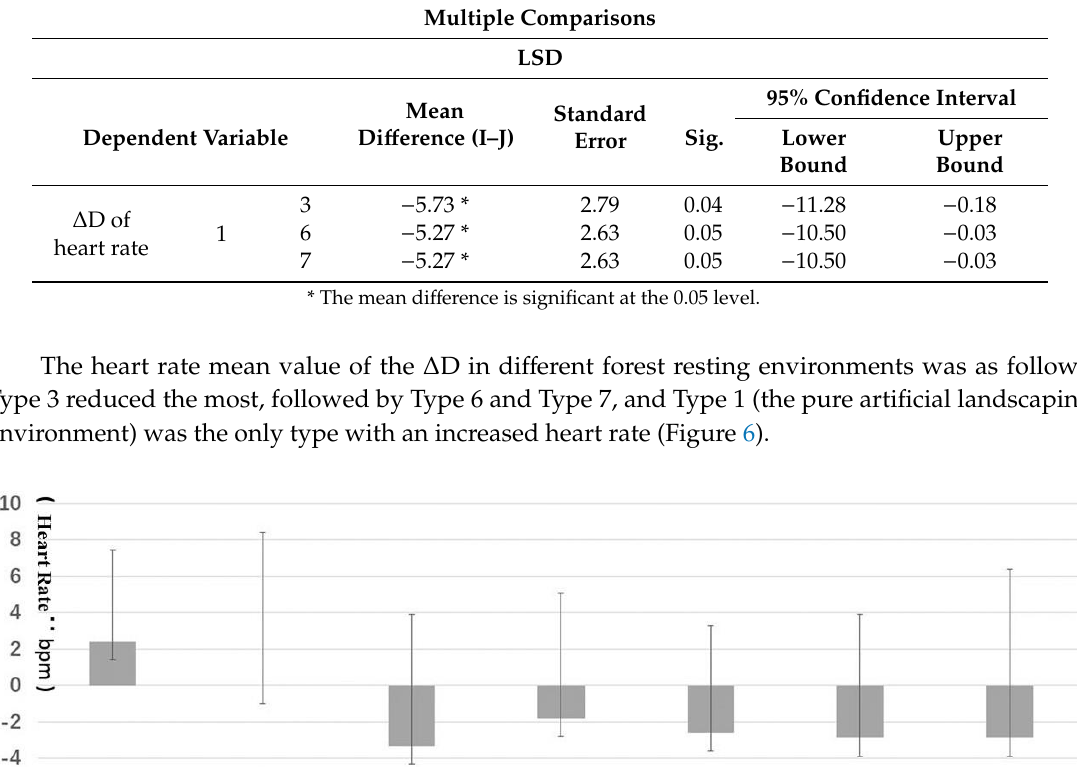
Table 3. Post-hoc multiple comparison of LSD with significant differences in the heart rate of the ΔD. Multiple Comparisons